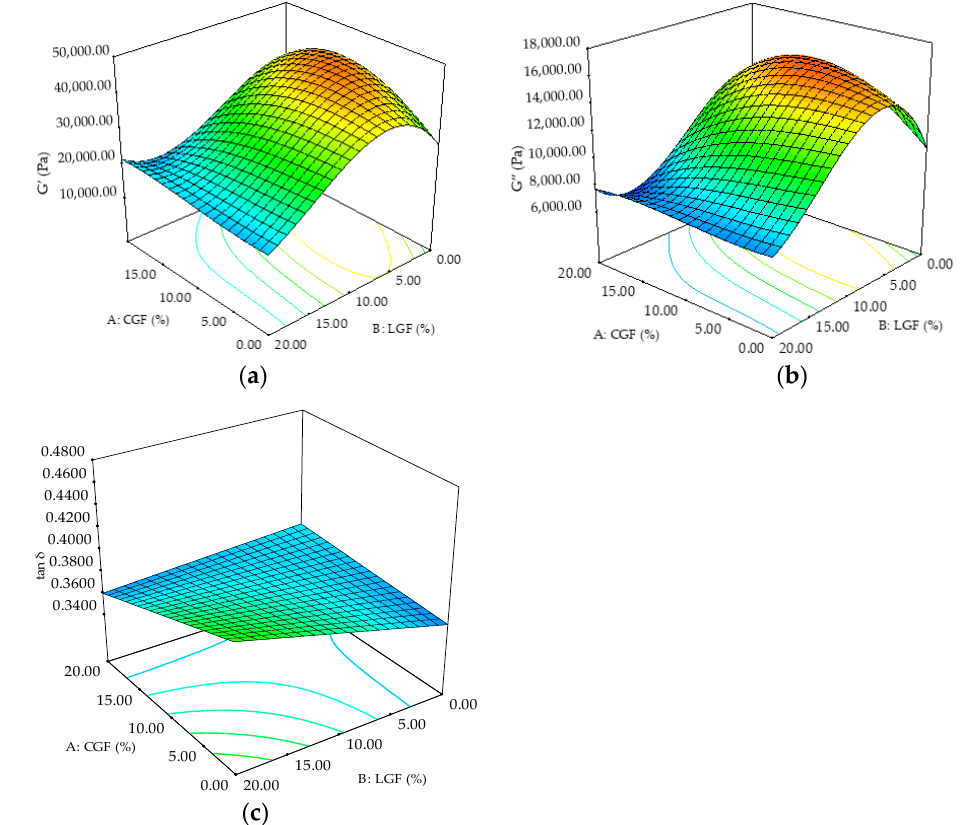
Figure 8. Response surface plot of ( a ) dough elastic modulus (G ′ ), ( b ) dough viscous modulus (G ″ ) and ( b ) loss tangent (tan δ ) as a function of chickpea germinated flour (CGF) and lupin germinated flour (LGF) addition.